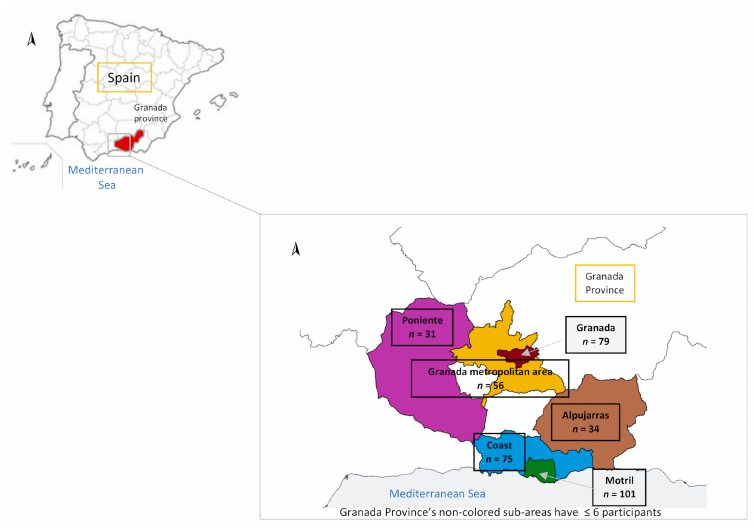
Figure 1. Map of Granada province (Southern Spain) with participants’ distribution by